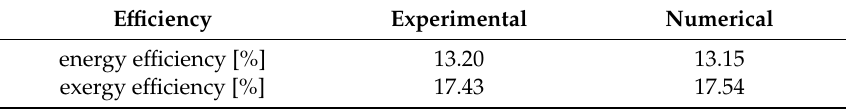
Table 4. Comparison between experimental and numerical results of e ffi ciency